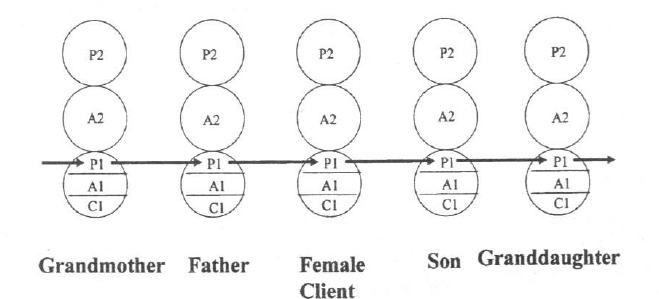
Figure 5: A Family Parade (adapted from Berne, 1972 p. 284) (Noriega, 2009 p.